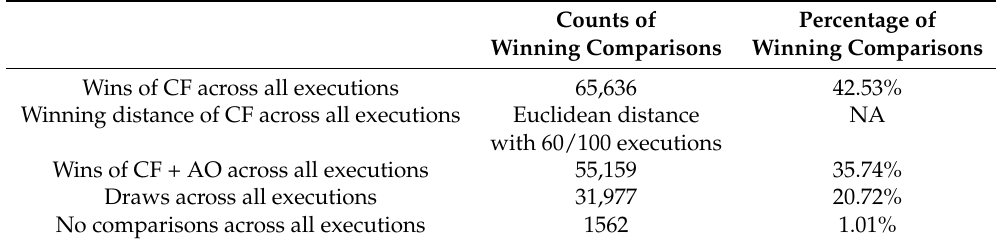
Table 9. Comparison between the recommendations given by the user-based CF algorithm against the user-based CF with an average aggregation operator that integrates five similarity and distance measures.